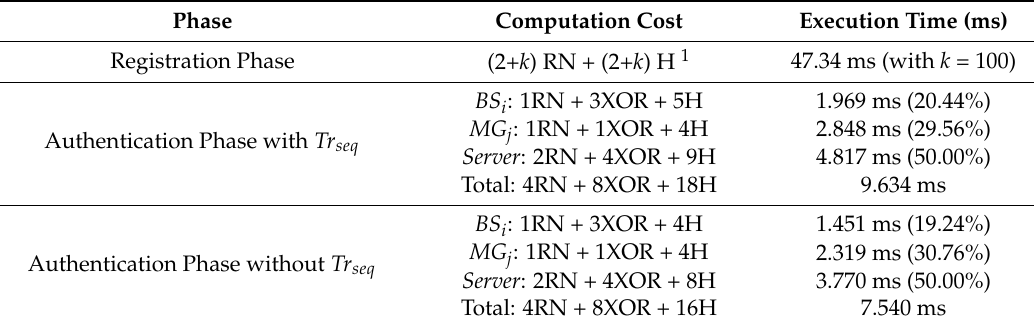
Table 4. Execution Time of the BSNCare+.